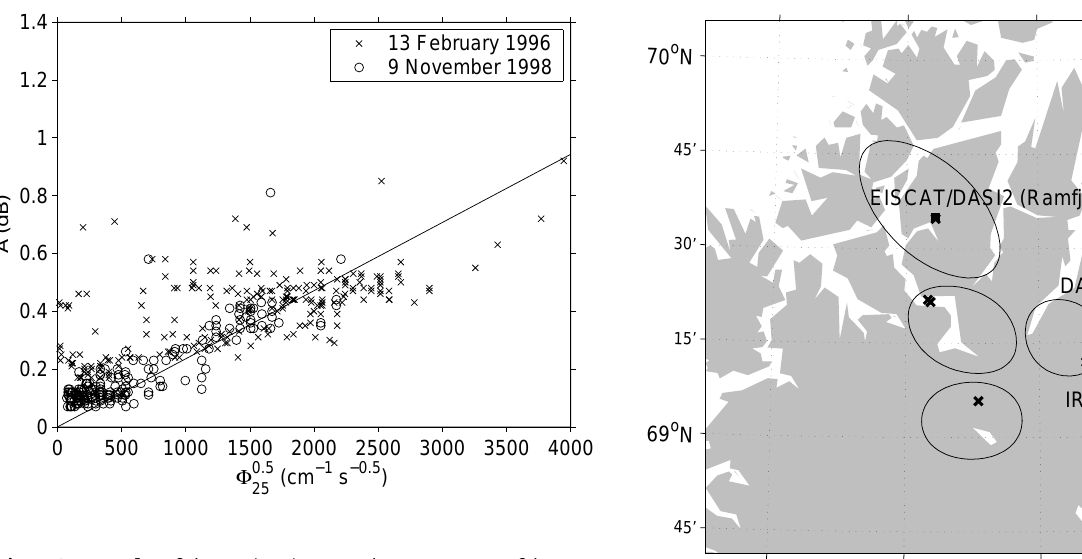
Fig. 1. Scatter plot of absorption A versus the square-root of the flux of electrons with energies exceeding 25keV ( 8 25 ) for the Kosch et al. (2001) data. The line is the least-squares fit of Eq. (4) to all points. Fig. 2. The locations of the instruments used in this study, marked by the squares. The rings indicate the − 3dB contours of four IRIS beams at 90km altitude. The crosses mark the locations of the EIS- CAT radar beam at 110km for all the scan positions used (note that the vertical position overlaps the instrument